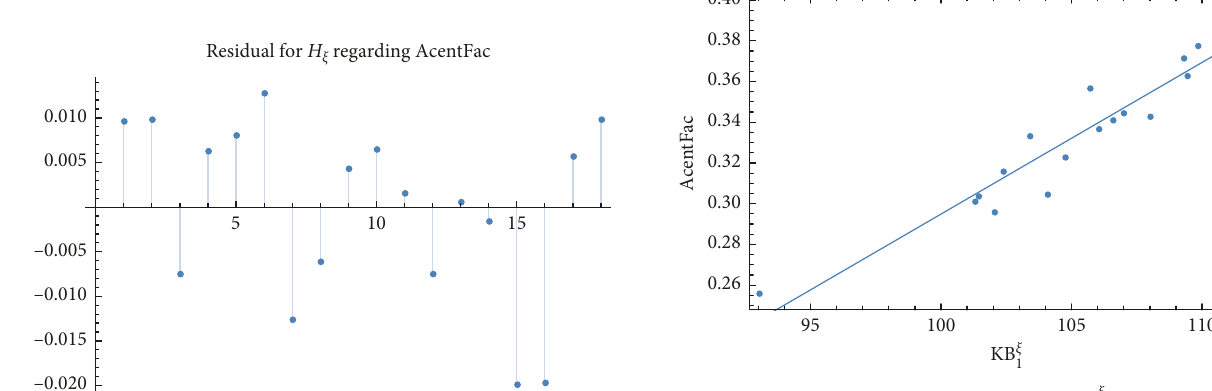
superimposed by 1